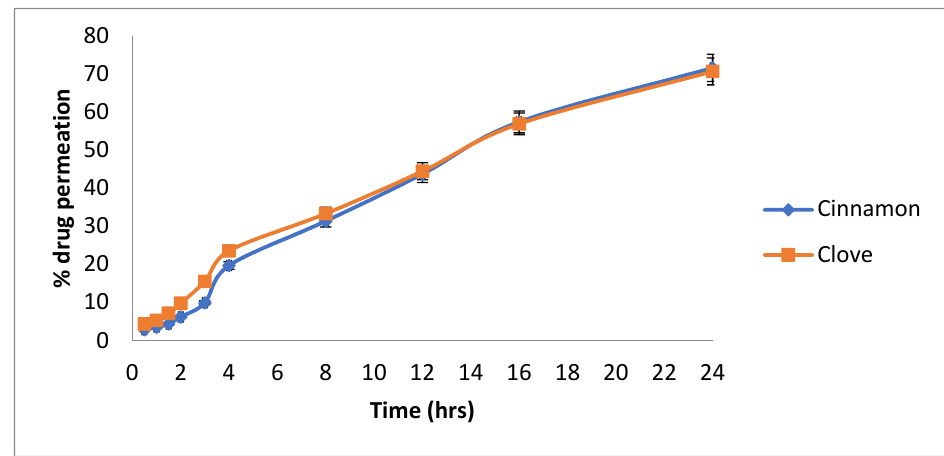
Figure 11. Permeation of cinnamaldehyde and eugenol through a goat buccal mucosa.